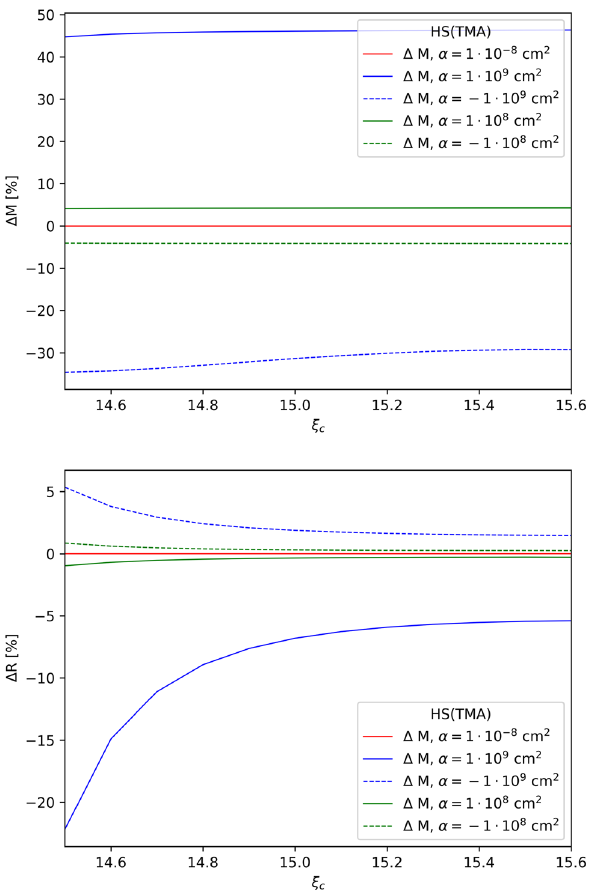
Fig. 8 Maximum mass allowed by an f ( R ) = R + α R 2 theory with α = − 4 × 10 9 cm 2 for the different EoS used in this paper, compared with the observed mass of the MSP J0740+6620 neutron star